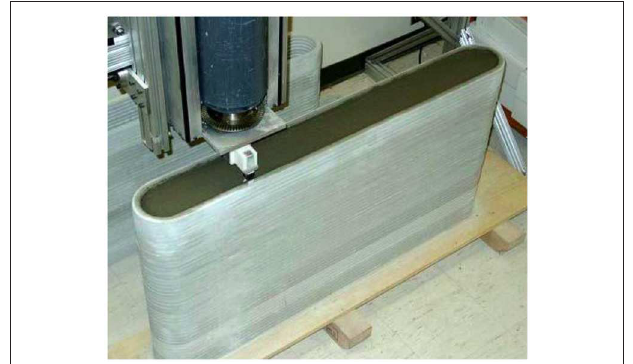
FIGURE 3 | Concrete wall synthesized via contour crafting technique. Figure adapted from Hwang and Khoshnevis (2004), with permission from Int. J. Industrial and Systems